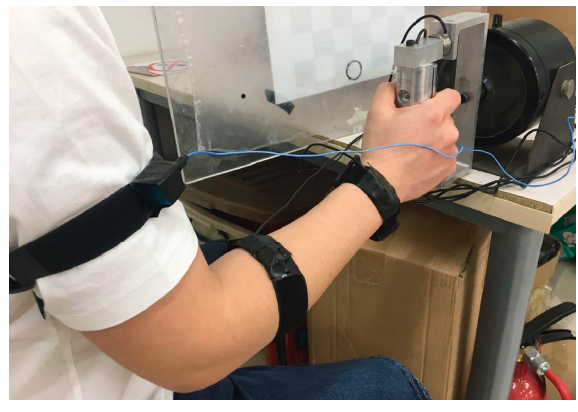
Figure 2: The operating posture of the experiment.